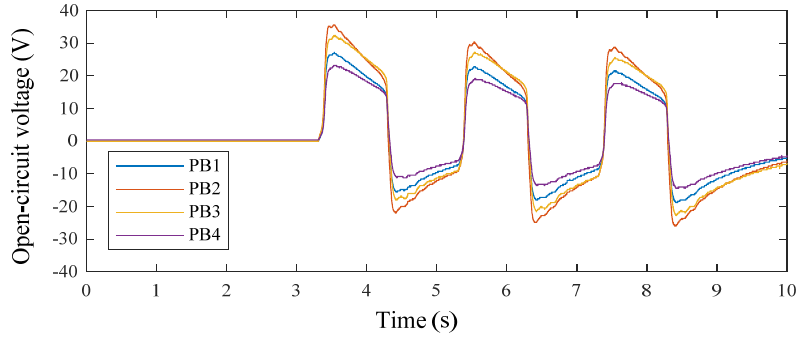
Figure 12. The open-circuit voltages of piezoelectric elements.